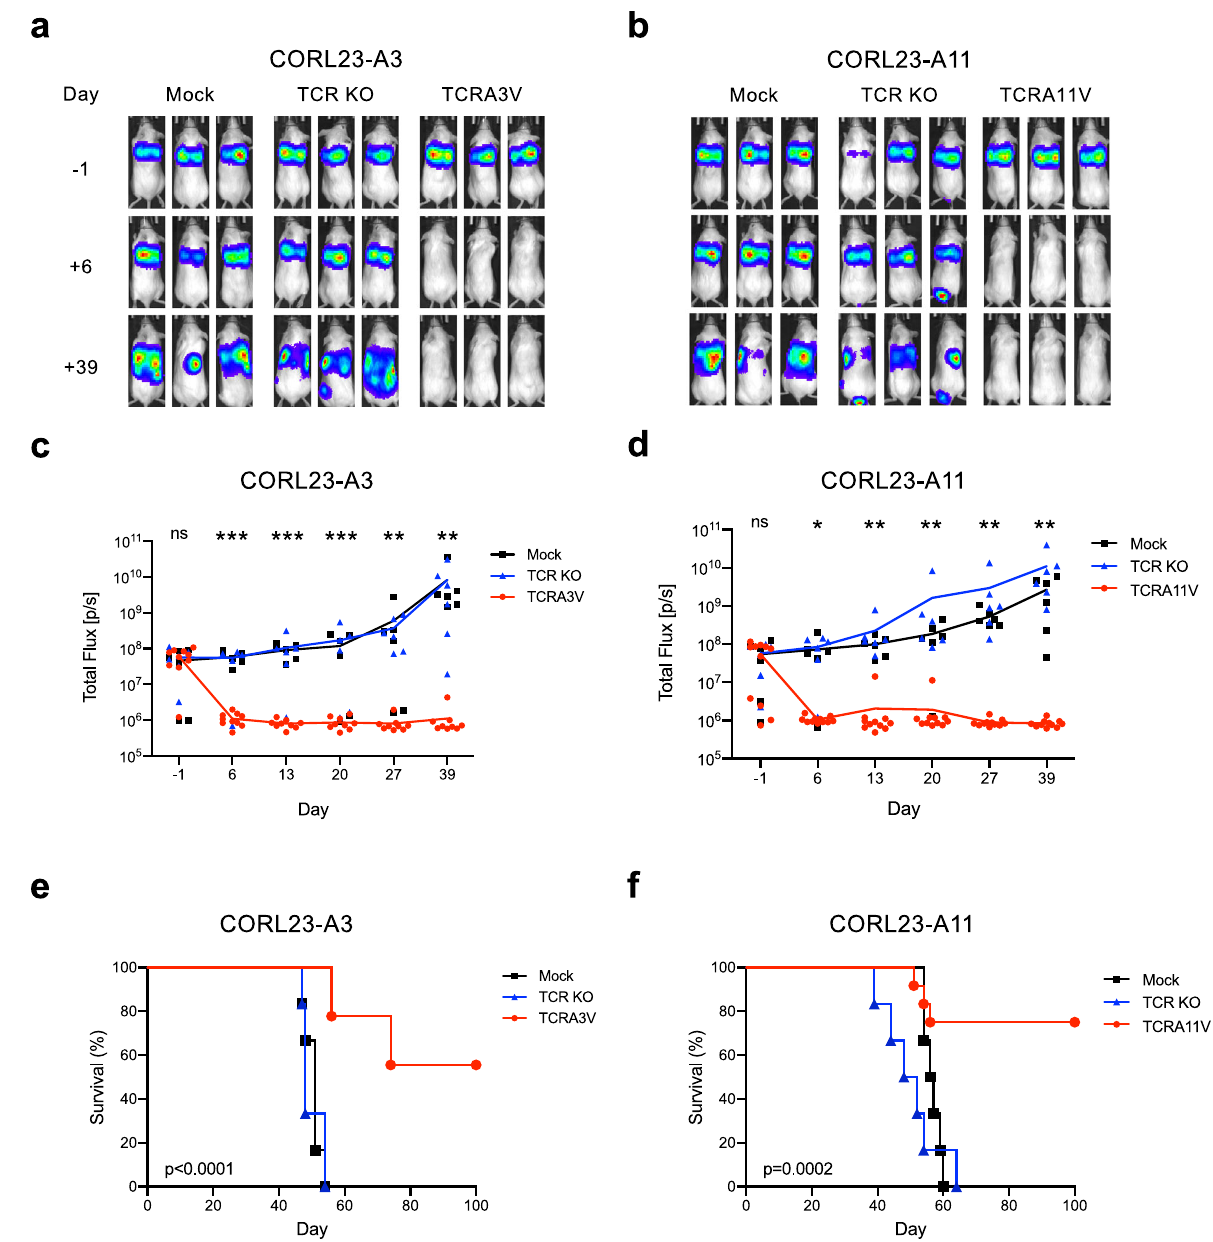
Fig. 6 Adoptive transfer of mKRAS-TCR T cells leads to in vivo eradication of KRAS G12V + tumor cells in a xenograft model of metastatic lung cancer. CORL23-A3 or CORL23-A11 tumors expressing CBR luciferase were engrafted into NSG mice via intravenous tail vein injection. Mice were left untreated (Mock) or treated with TCR αβ null (TCR KO) or mKRAS-TCR engineered CD8 + T cells 4 days after tumor engraftment. Tumor burden was assessed by bioluminescence imaging before and after treatment, and overall survival was monitored over time. Representative bioluminescence imaging prior to and following treatment of NSG mice bearing a CORL23-A3 pulmonary tumors treated with TCRA3V T cells and b CORL23-A11 pulmonary tumors treated with TCRA11V cells compared to control groups. Total Flux quanti fi cation over time of c CORL23-A3 and d CORL23-A11 tumor-bearing mice as shown in ( a ) and ( b ). Colored lines represent mean Total Flux values over time with individual data points corresponding to treatment groups presented as indicated in the fi gure legend. * p < 0.05, ** p < 0.01, *** p < 0.001; one-way ANOVA followed by Tukey ’ s HSD post-test comparing Mock and TCRA3V or TCRA11V treated mice. No statistical difference was observed between Mock and TCR KO treated mice. Kaplan – Meier analysis of overall survival of e CORL23-A3 and f CORL23-A11 tumor-bearing mice. Colored lines correspond to treatment groups as indicated in the fi gure legend. p values as indicated; log-rank testing comparing Mock and TCRA3V or TCRA11V treated mice. No statistical difference was observed between Mock and TCR KO treated mice. Number of mice in representative experiment is as follows: CORL23-A3 Cohort — Mock ( n = 6), TCR KO ( n = 6), TCRA3V ( n = 10). CORL23-A11 Cohort — Mock ( n = 6), TCR KO ( n = 6), TCRA11V ( n = 12). Source data are provided as a Source Data fi